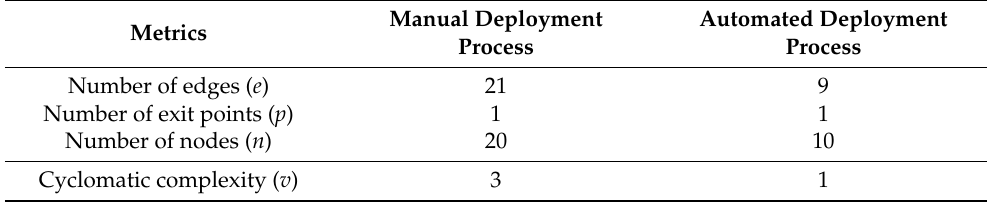
Table 4. Cyclomatic complexity of the manual and automated deployment processes. Manual Deployment Automated Deployment Metrics Process Process Number of edges ( e ) 21 9 Number of exit points ( p ) 1 1 Number of nodes ( n ) 20 10 Cyclomatic complexity ( v ) 1